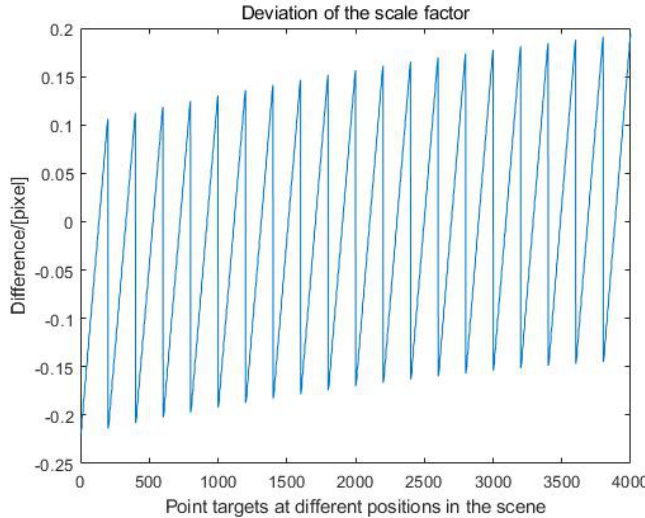
Figure 14. Deviation of scale factor k between any points and the target P ( 0,0,1 ) . Actually, the